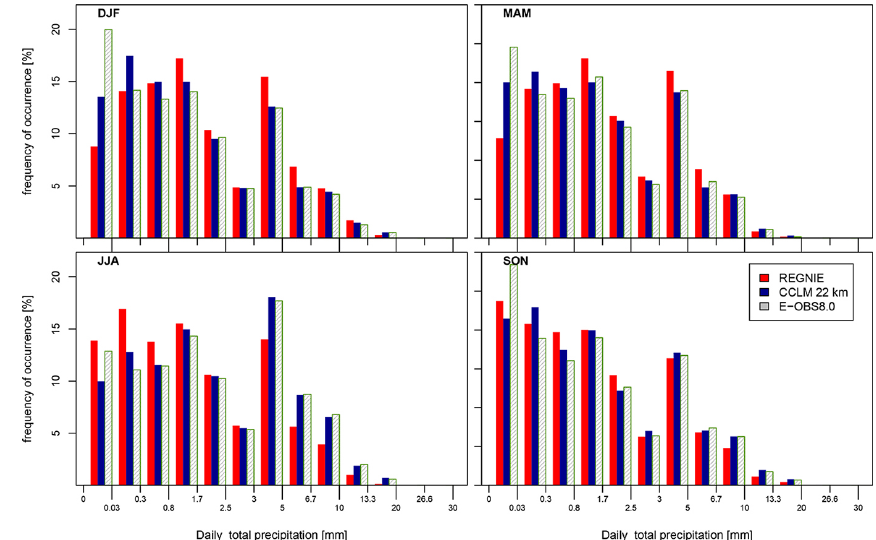
Figure 9. Histogram of Germany mean daily precipitation sums [mm] from 1951 to 2009: REGNIE (red bars), coastDat2-CCLM (blue bars), and E-OBS8.0 (shaded).The frequency is given in %.